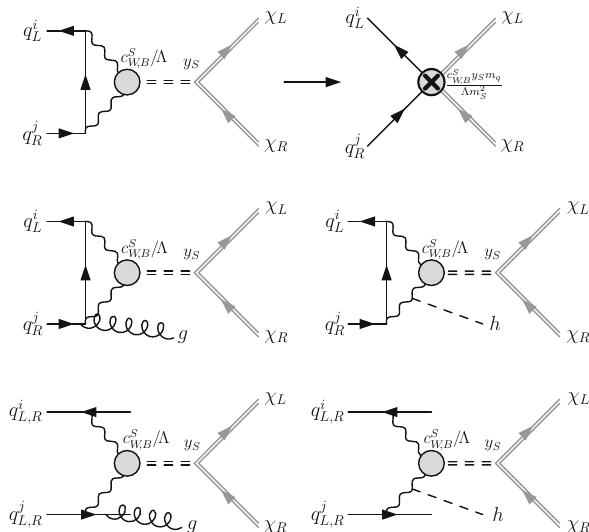
Fig. 8 Diagrams contributing to nuclear interaction with fermionic DM (first row) and DM observables at hadron colliders, turning on the interactions ∼ c S and ∼ y S . The diagrams are similar for pseudo- W scalar mediators, employing the corresponding tilded coefficients, as discussed before. The diagrams for scalar DM are equivalent with v . See text for replacement y S → λ (cid:3) S χ s